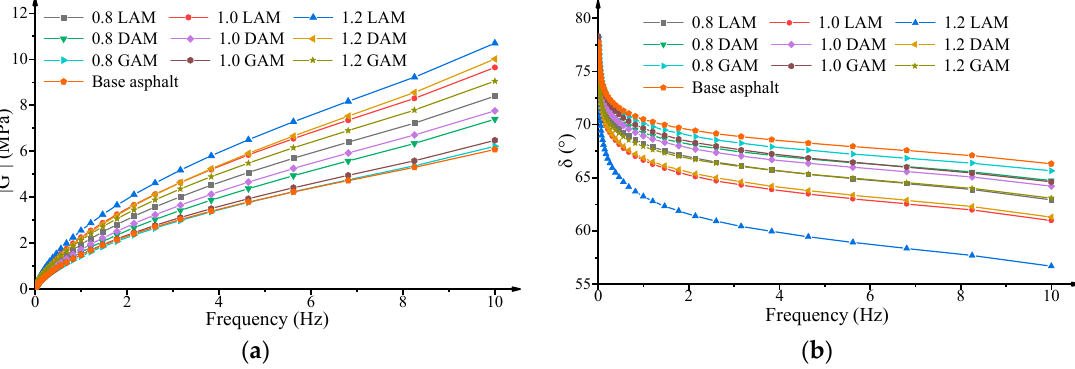
Figure 1. Frequency sweep curves for the base asphalt binder and asphalt mastics. LAM: limestone asphalt mastic, DAM: diabase asphalt mastic, GAM: granite asphalt mastic. ( a ) | G ∗ | versus frequency; ( b ) δ versus frequency .